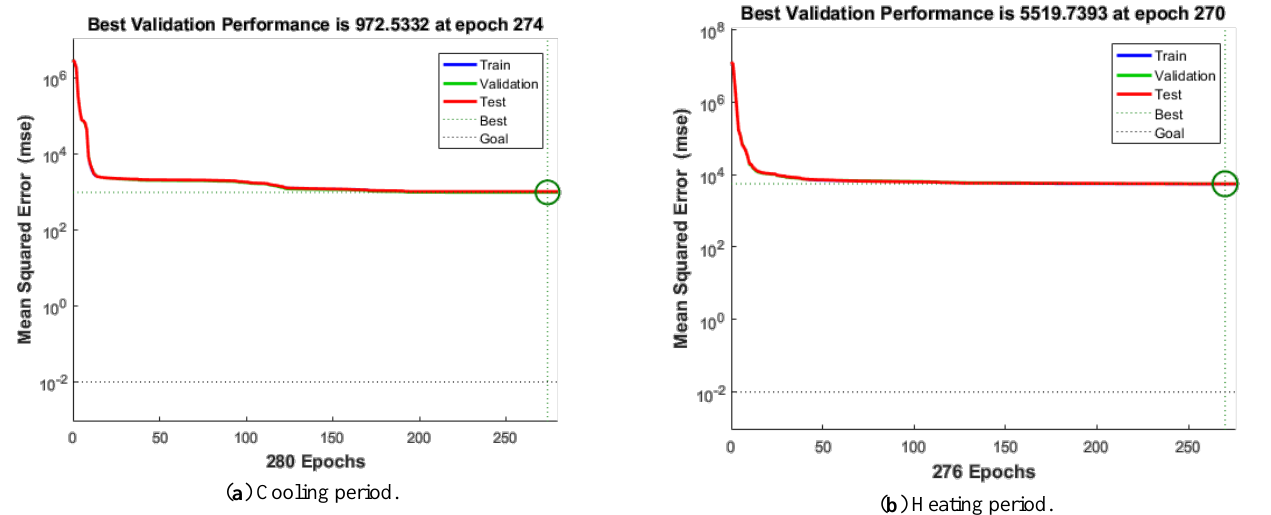
Figure 5. Mean squared error (MSE) analysis of neural network (ANN) optimal control model.